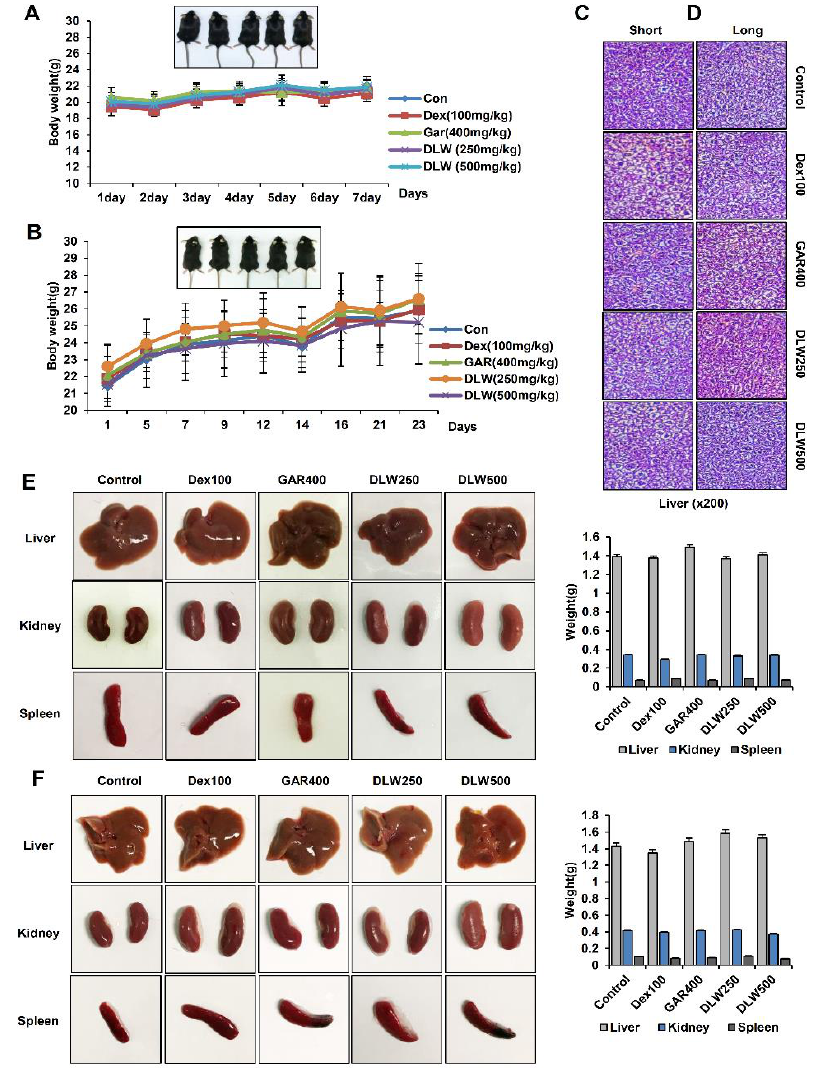
Figure 1. In vivo toxicity of D. morbifera water extracts (250 mg/kg, DLW250; 500 mg/kg, DLW500). DLW250 and DLW500 did not demonstrate short-term or long-term toxicity in the in vivo mouse model. ( A ) In vivo short-term toxicity of DLW250 and DLW500. ( B ) In vivo long-term toxicity of DLW250 and DLW500. ( C , D ) After 8 or 30 days of DLW250 and DLW500 treatment, hematoxylin and eosin staining of mouse liver specimens was carried out. Representative images are shown. ( E ) In vivo short-term toxicity of DLW250 and DLW500 with respect to organ (the liver, kidney, and spleen) weight. ( F ) In vivo long-term toxicity of DLW250 and DLW500 with respect to organ